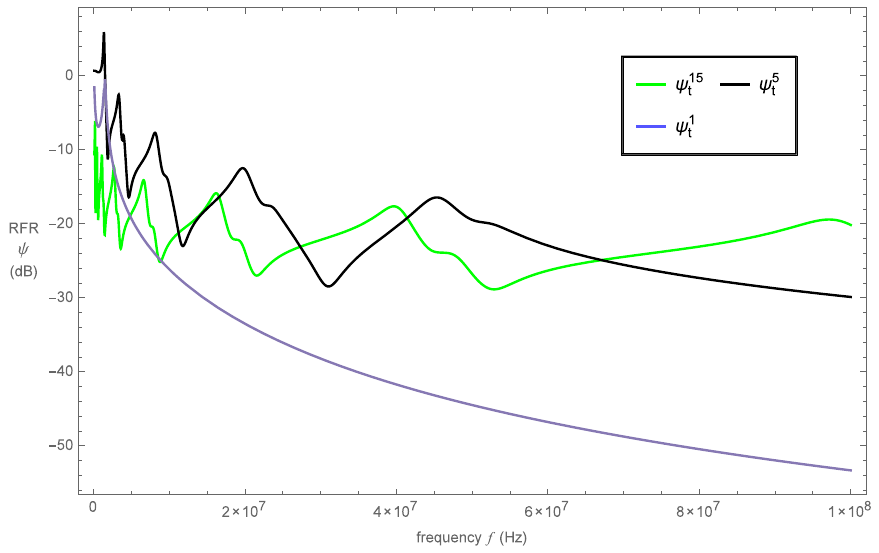
Figure 6. Non-dimensionalized RFR ψ (dB) versus frequency f (Hz) for the Sierpinski tetrix fractal-inspired sensor at fractal generation levels one, five and